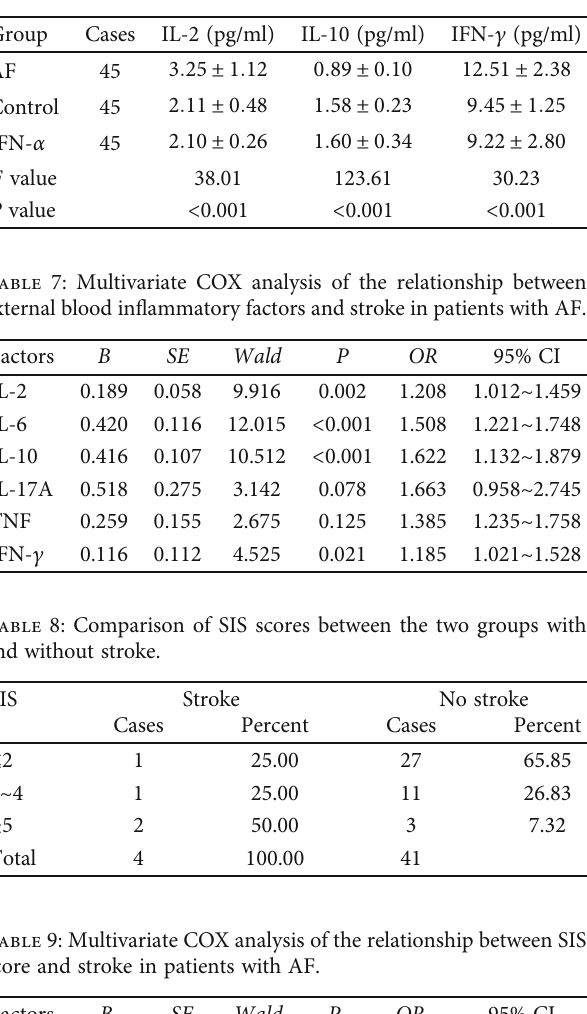
Table 6: E ff ects of PD-1/PD-L1 signaling pathway on T lymphocyte immune function in patients with AF ð x ± s Þ .